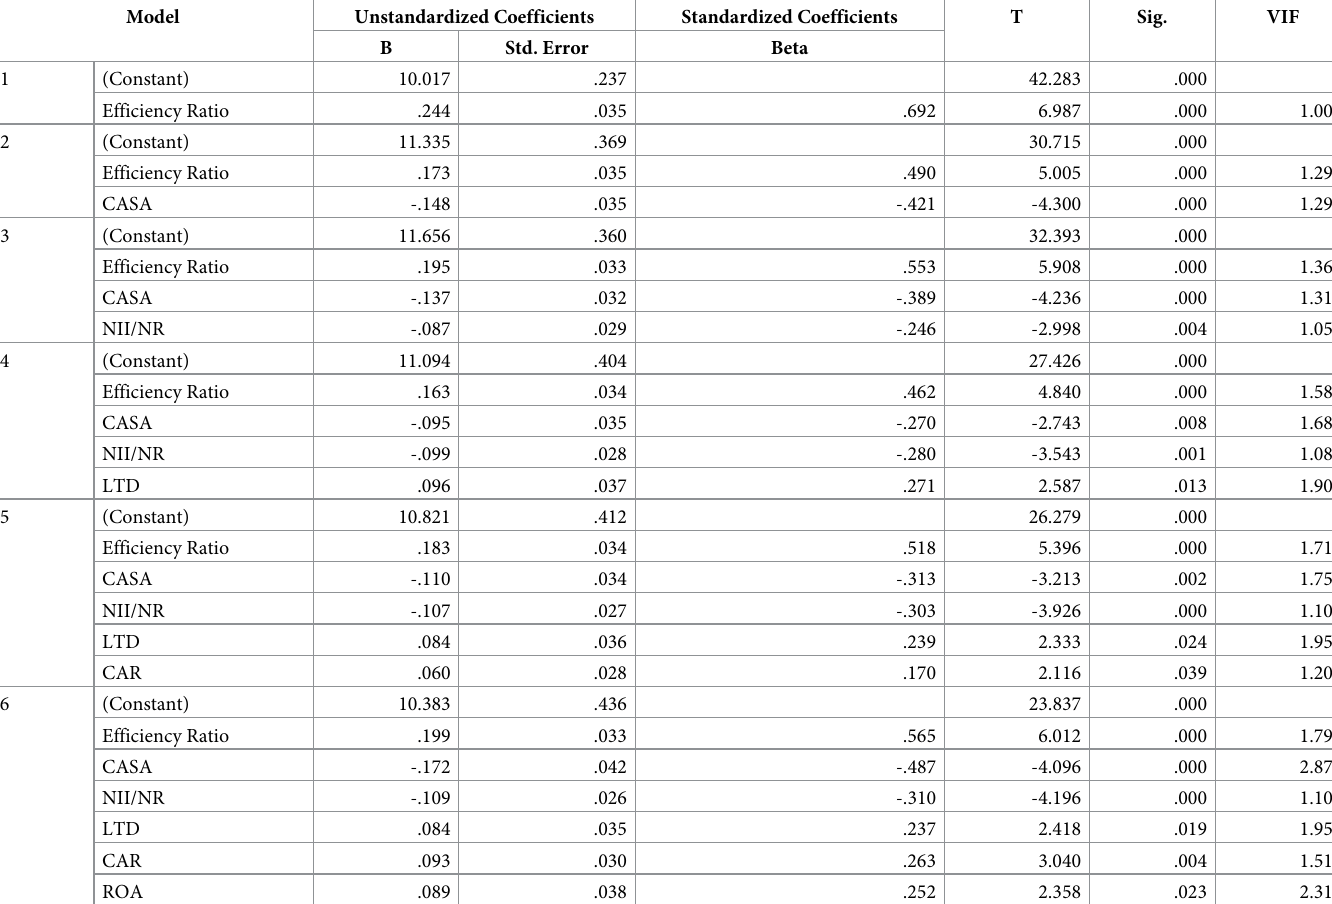
Table 6. Coefficients of the linear regression